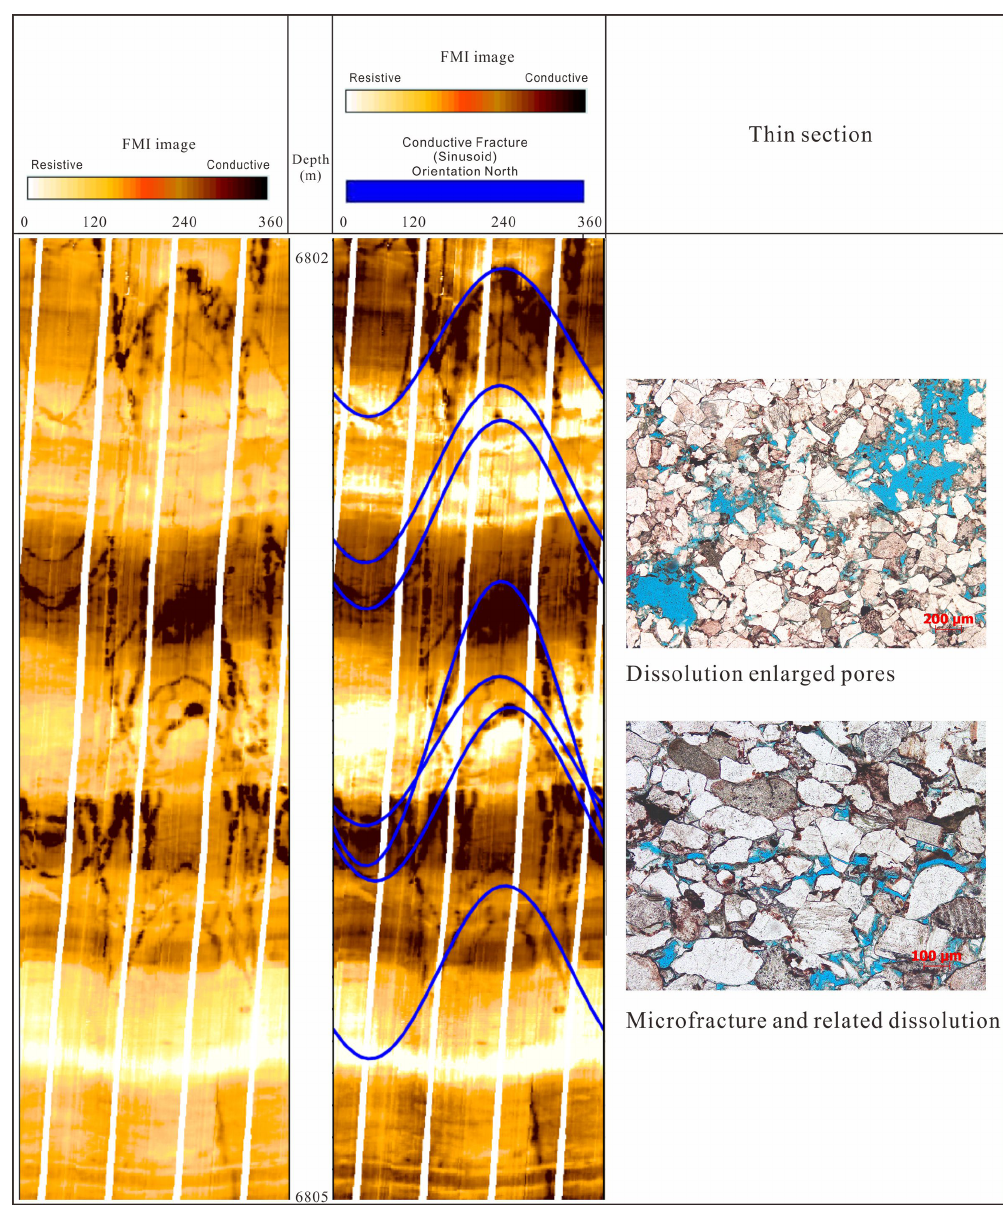
Figure 17. Dissolution pores along fracture surfaces (Bozi